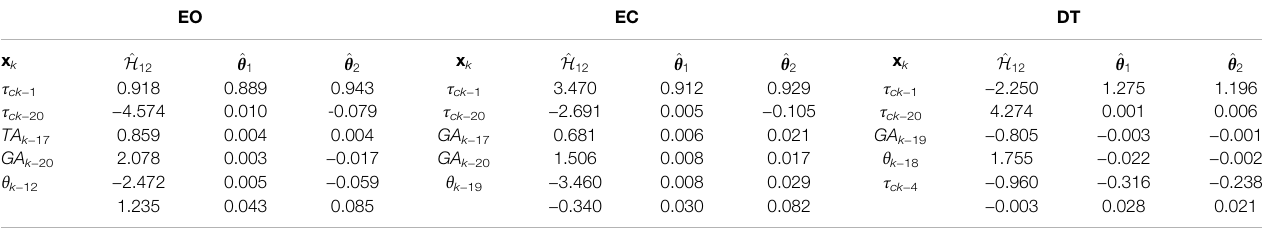
TABLE 2 | Regression vector ( x k ), estimated boundary hyperplane ( ^ H 12 ), and sub-models coef fi cients ( ^ θ 1 and ^ θ 2 ) for the identi fi ed models in the three conditions, i.e., EO, EC, and DT. EO EC DT